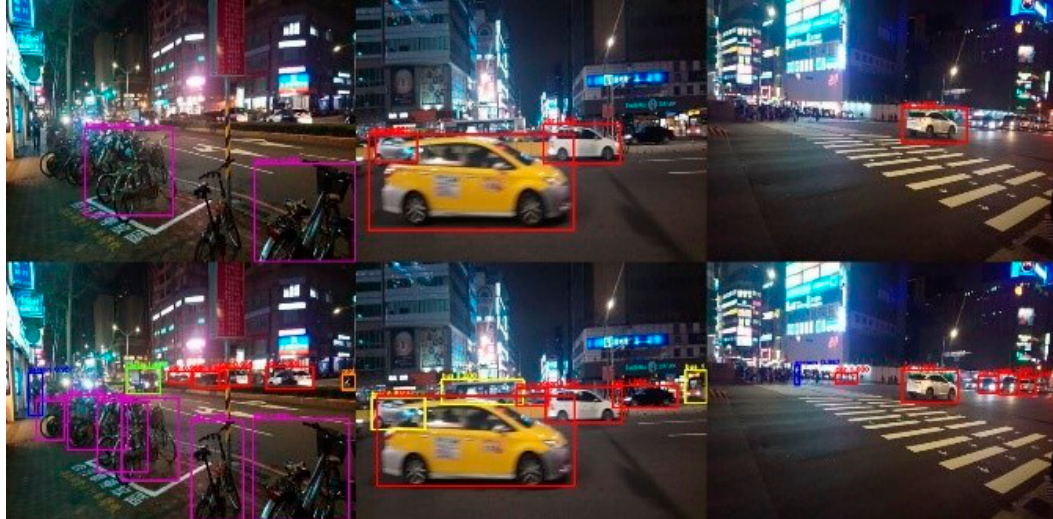
Figure 21. Outputs from two variants of the Faster R-CNN [5] with ResNet101 [2]. Upper row: Ordinary model trained with PASCAL VOC 2007 [6]. Lower row: Proposed system trained with our nighttime data.